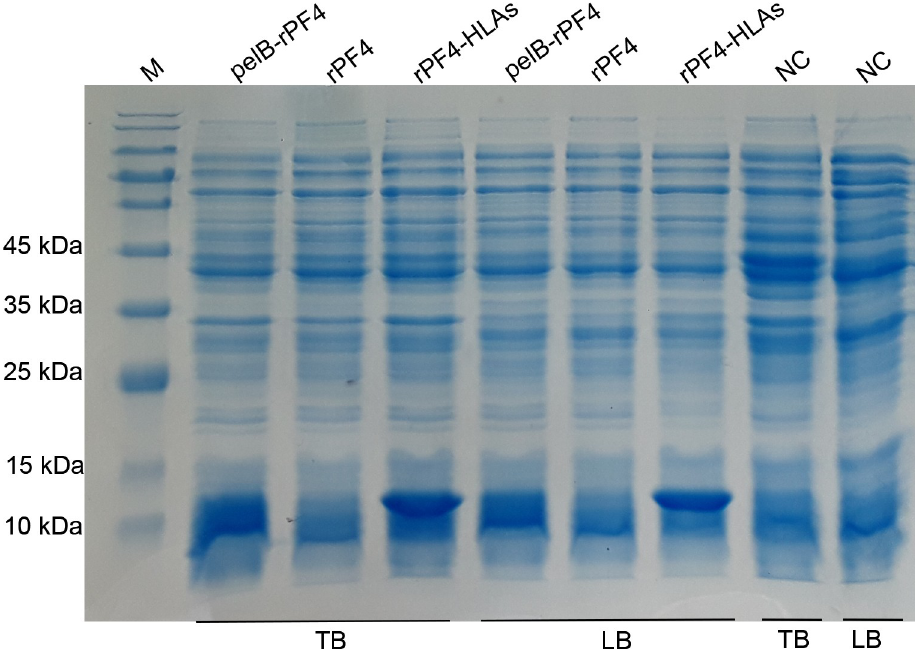
Fig 2. Analyzing the cytoplasmic expression of the pelB-rPF4, rPF4-HLAs, and rPF4 constructs. Expression was induced by 2 mM IPTG for 2 h in LB or TB media and the bacterial lysates were subjected to analysis using SDS-PAGE. All the constructs indicated an efficient cytoplasmic protein production; however, expression in the TB medium was found to be significantly improved compared to the LB medium. As an intrinsic property of the lac operon, a minor leaky expression from the rPF4 construct was observed in the non-induced groups. NC represents the non-induced groups serving as negative control. M denotes the molecular weight marker.